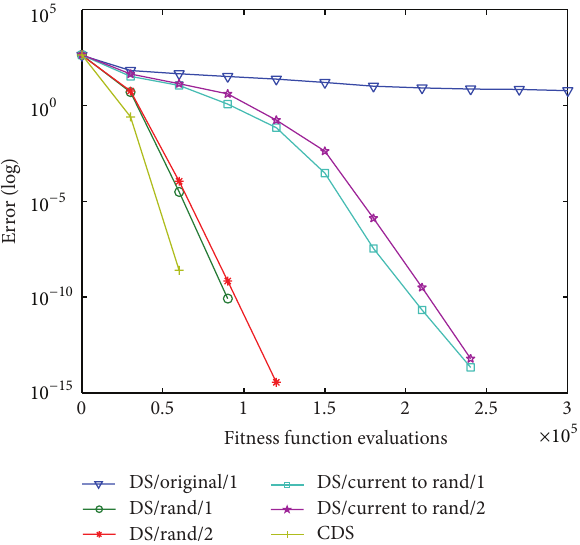
Figure 10: Comparison of performance of six algorithms for minimization of 𝑓 11 with dimension